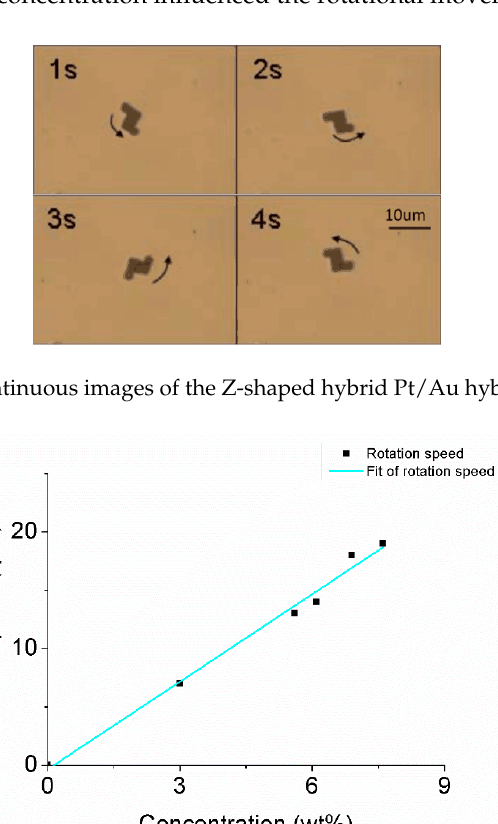
Figure 10 . The rotation speed accelerated as the concentration of hydrogen peroxide increased.